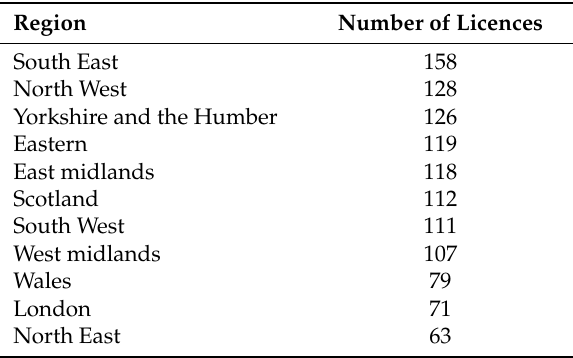
Table A7. Number of pet shop licences by UK region.